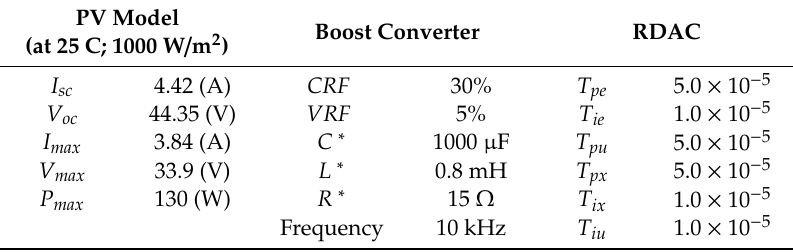
Table 2. System parameters of PV model, Boost converter, and robust direct adaptive controller